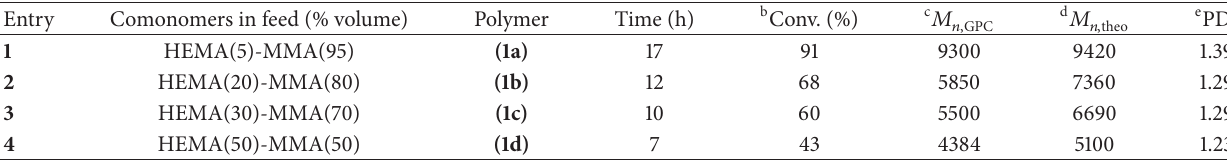
Table 1: Conditions a and results for the synthesis of P(HEMA- co -MMA).